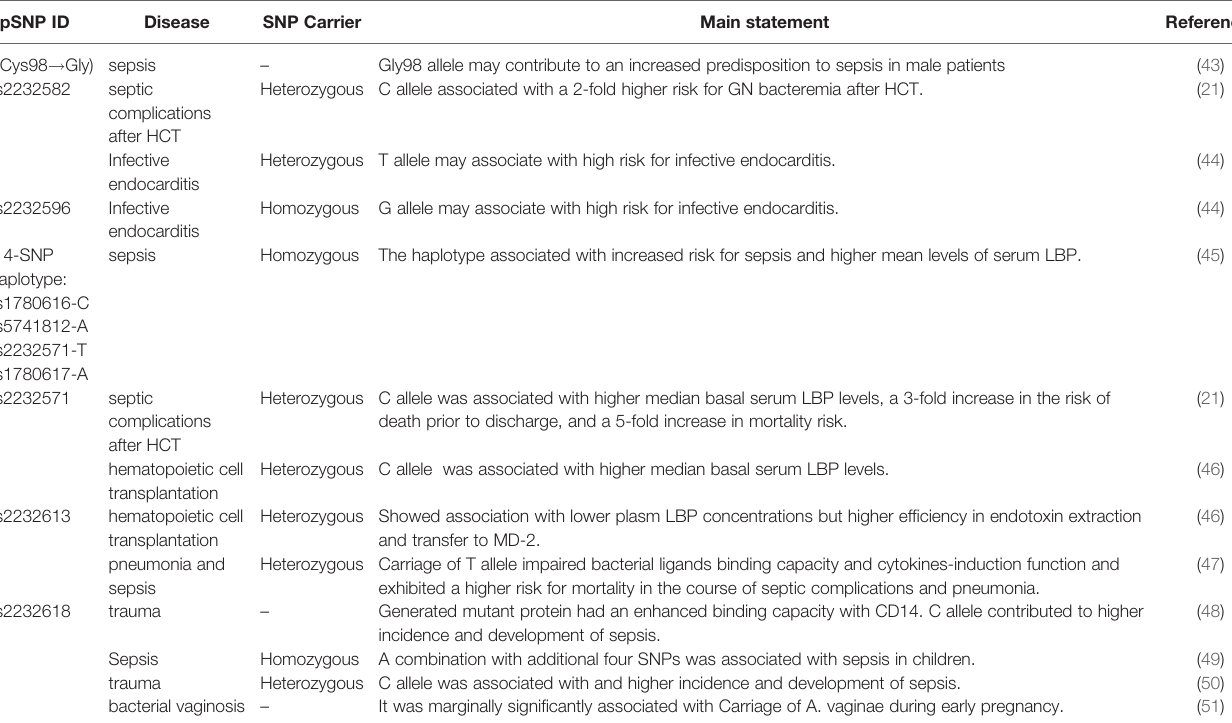
TABLE 1 | Impact of SNPs in LBP gene on infectious diseases, sepsis and septic